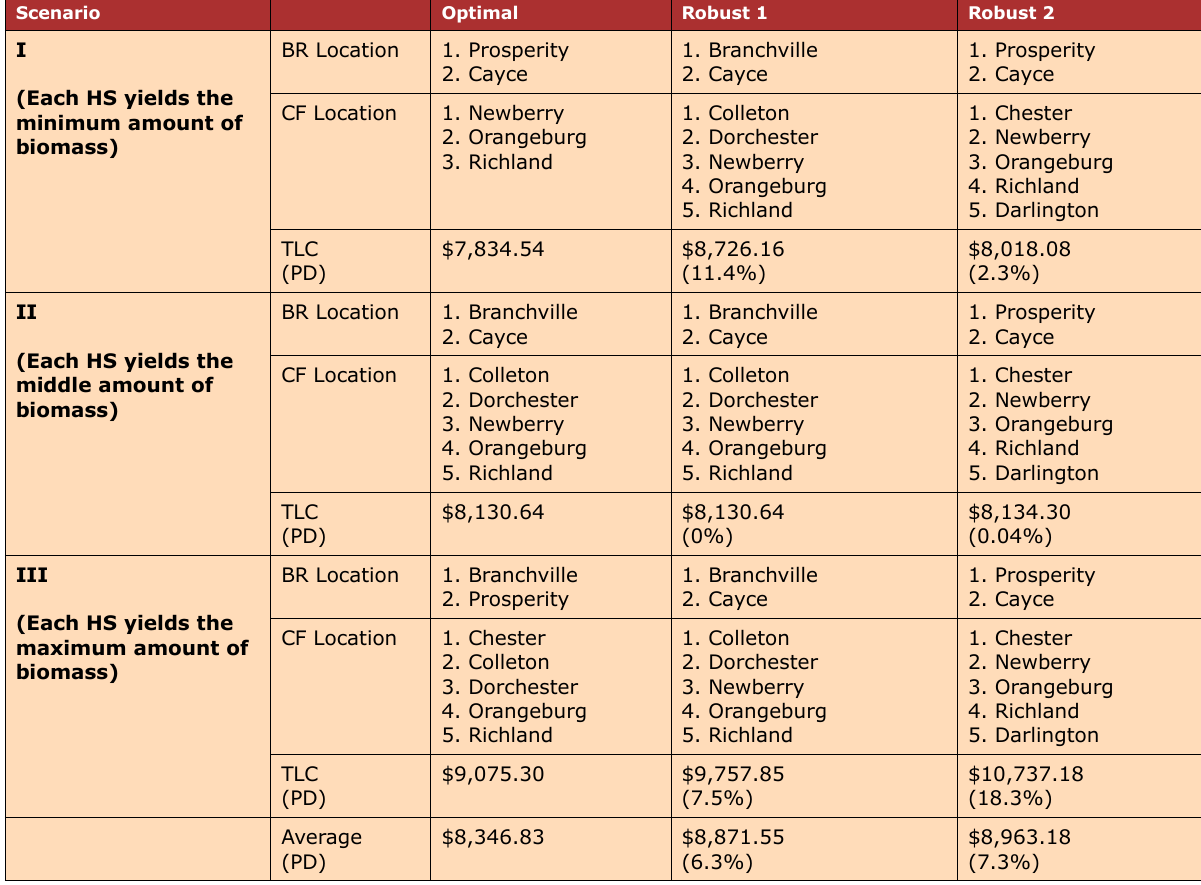
Table 4. Comparison between Results of Optimal and Robust